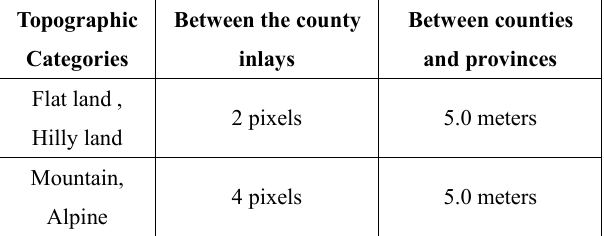
Table 2 . Edge accuracy of 1:10000 orthophoto